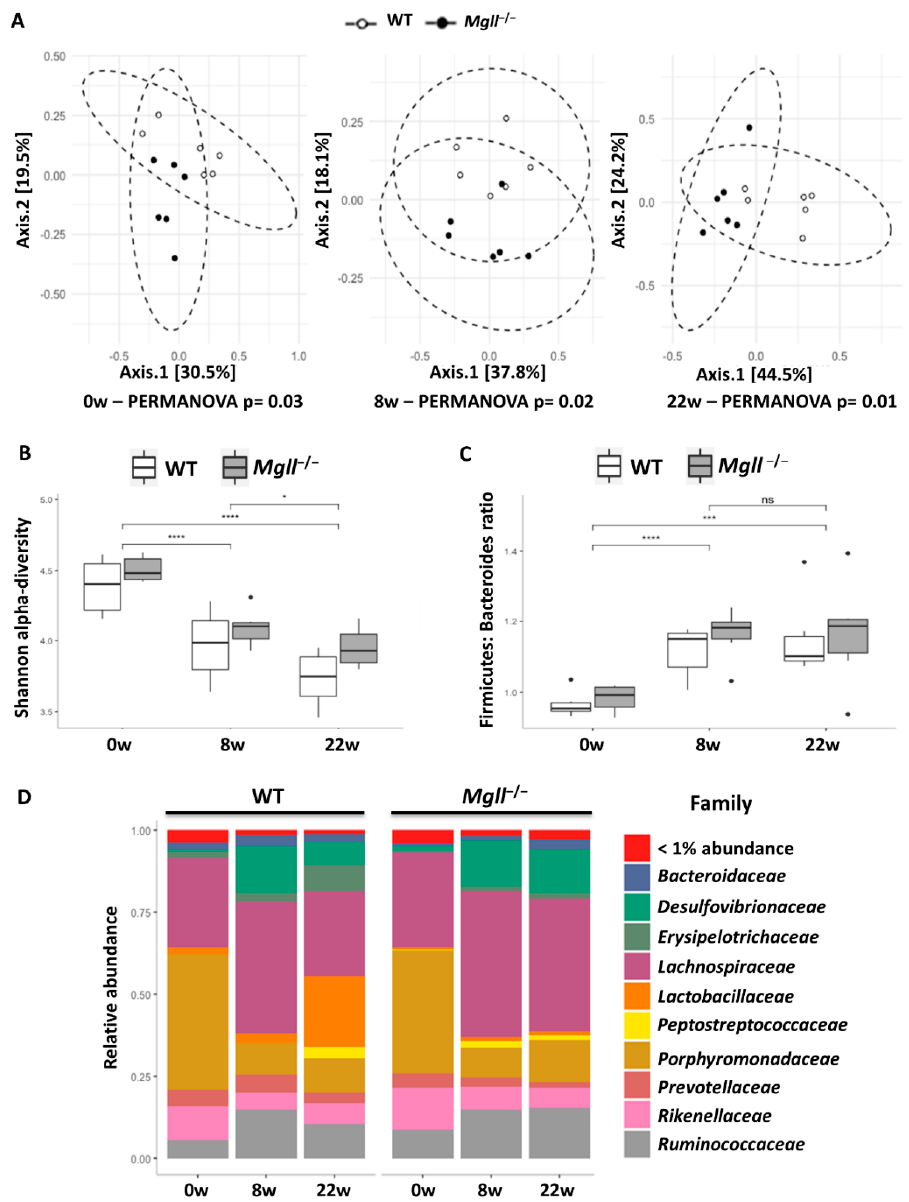
Figure 3. The microbiomes of WT and Mgll − / − mice differ under both chow and HFD feeding. ( A ) Principal coordinate analysis (PCoA)of microbiomes from WT and Mgll − / − mice on chow diets (0w; left), HFD feeding for 8 weeks (8w; middle) and 22 weeks (22w right). Permutational multivariate analysis of variance (PERMANOVA) p values are indicated for each time-point. ( B , C ) Shannon alpha-diversity index ( B ) evaluating gut microbiota richness and evenness and Firmicutes to Bacteroidetes ratio ( C ). Asterisks displayed above brackets represent Wilcoxon p -values * p < 0.05, *** p < 0.001, **** p < 0.0001, ns; not significant, between diets. No significant di ff erences were obtained between genotypes. ( D ) Relative abundance according to genotype at family